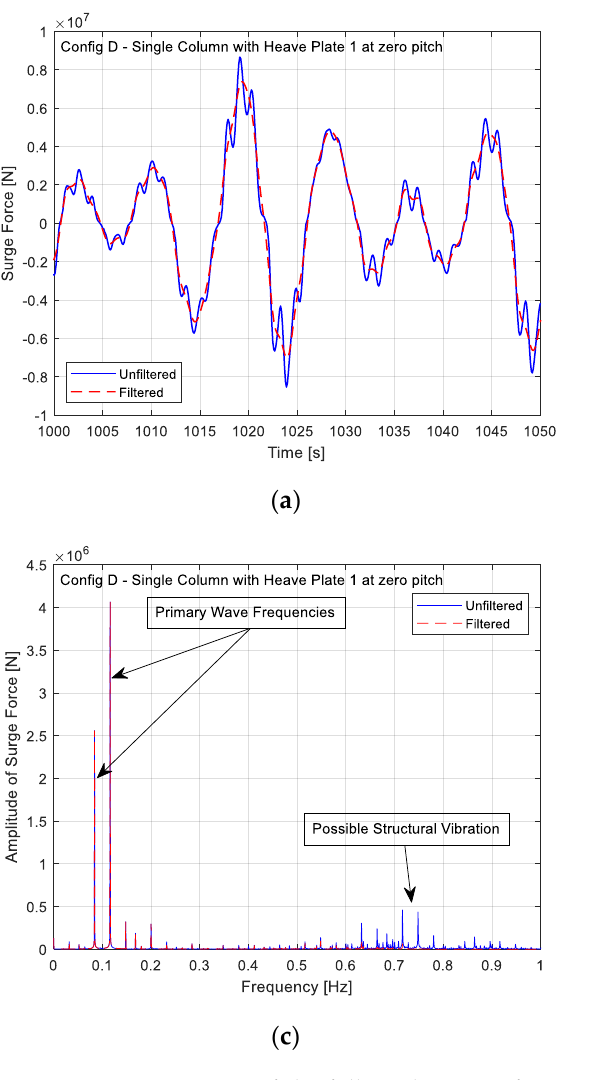
Figure 12. Comparison of the full − scale surge − force time series ( a , b ) and amplitude spectra ( c , d ) before and after filtering out the structural vibration. The measured surge force with the bichromatic wave B1 is shown as an example. Structural vibration tends to be more significant with the single − column configurations such as Configuration D shown in ( a , c ), whereas measurements from the three − column configurations do not contain significant structural vibration as demonstrated in ( b , d ) with the upstream column of Configuration P. To have zero phase shift, the low − pass − filtered signals were obtained by first filtering in the forward direction and then in the backward direction with a fifth − order Butterworth filter with a cutoff frequency of 0.6